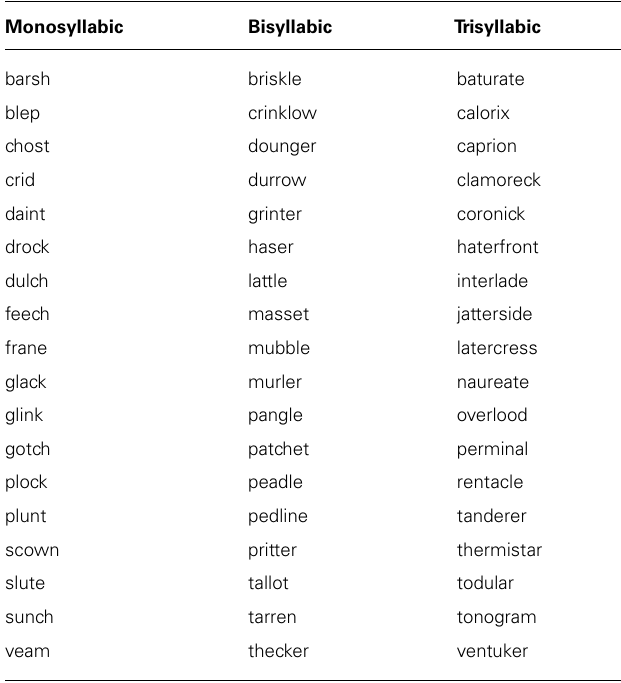
Table 1 | Nonce words used in Experiments 1 and 2, organized by syllable